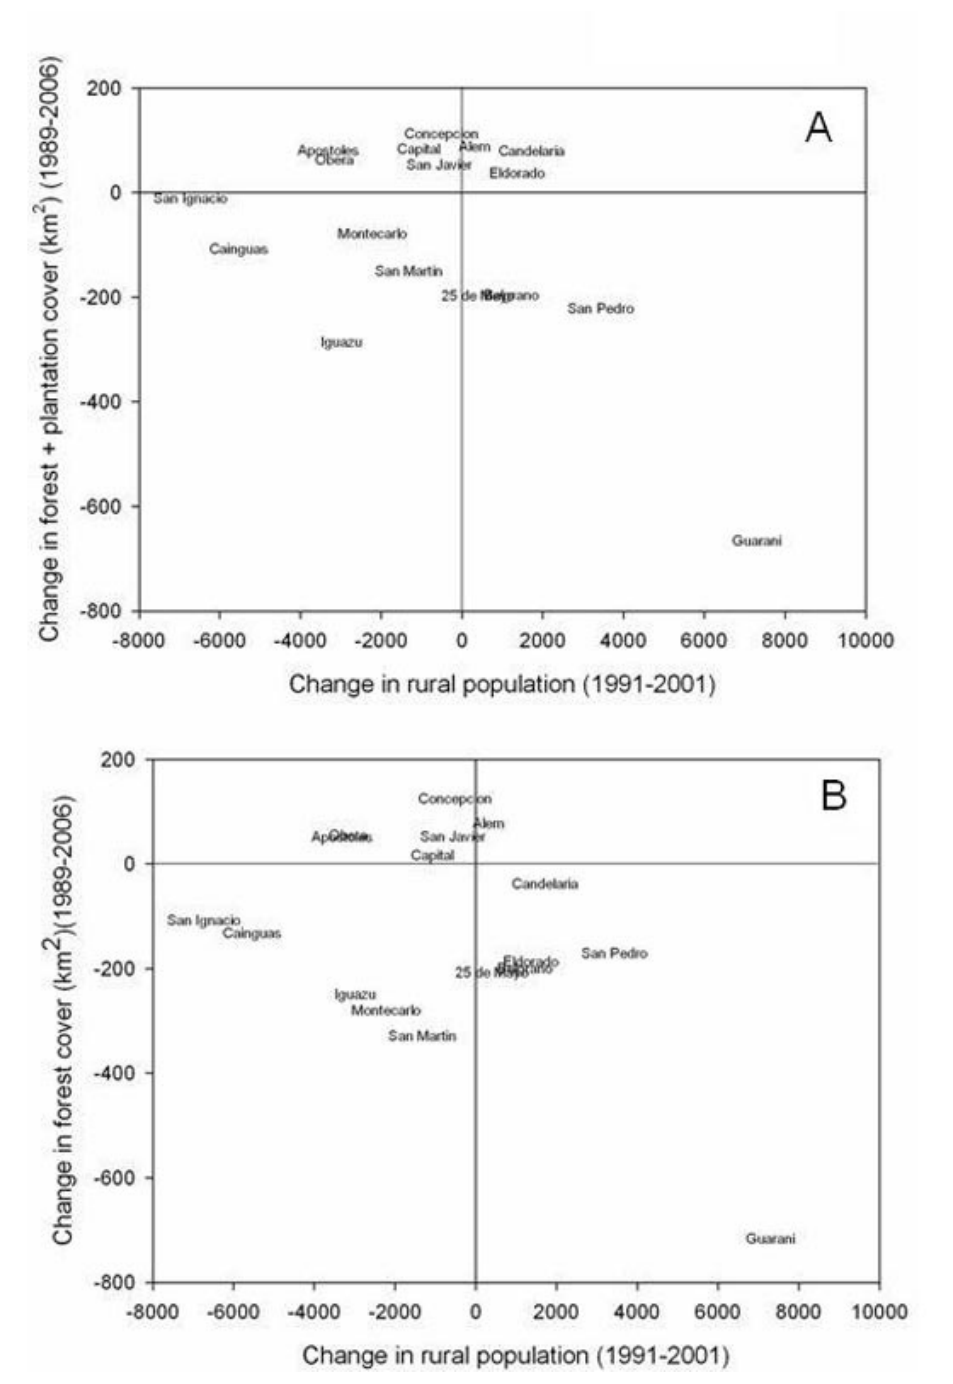
Fig. 6. Relationship between the change in (A) forest and plantation cover and (B) native forest cover between 1989 and 2006 and the change in the rural population between 1991 and